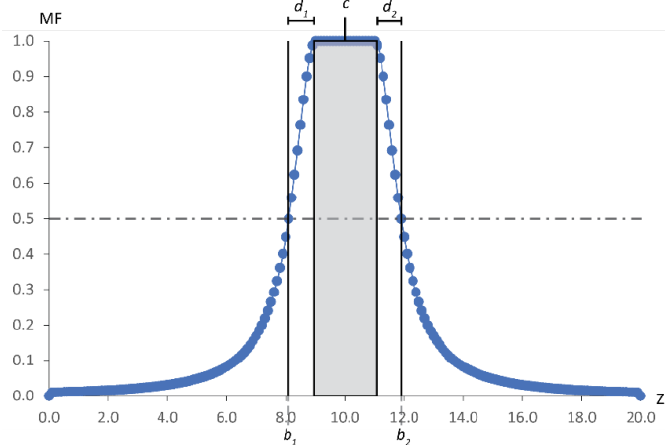
Figure 2. Bounded transition zone sinusoidal membership function.